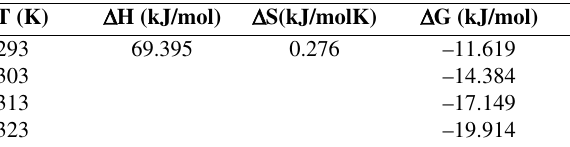
Table 3. Thermodynamic parameters for the adsorption